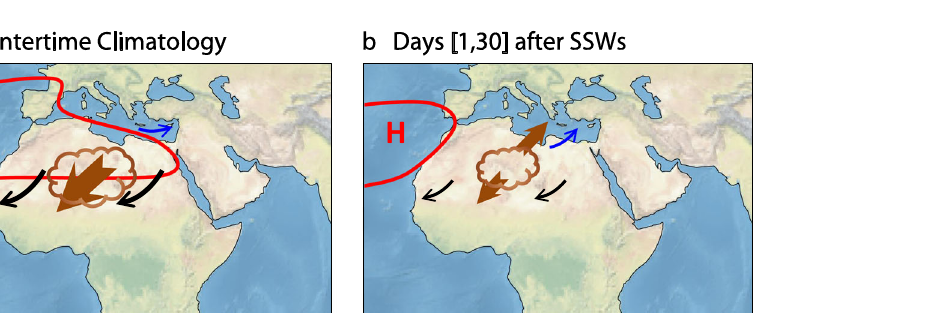
Fig. 2 | Observed changes in surface wind fi elds within the Eastern Mediterra- nean and West Africa. The Eastern Mediterranean and West Africa correspond to the two red boxes shown in Fig. 1c. a Bivariate histogram of surface dust con- centrations (from the CESM2 simulation) and surface wind directions (from the MERRA2 reanalysis) at all grid points within the Eastern Mediterranean during 1980/81-2013/14 extended winters (from November to March, NDJFM), with colors indicating the probability of occurrences falls within each bin. For surface wind directions, “ NE'', “ SE'', “ SW'', and “ NW ” indicate north-easterlies, south-easterlies, south-westerlies, and north-westerlies, respectively. b Histogram of surface wind directions atallgrid pointswithin the Eastern Mediterraneanduring SSW episodes (gray fi lled bars) and during 1000 sets of non-SSW episodes (see Methods). For